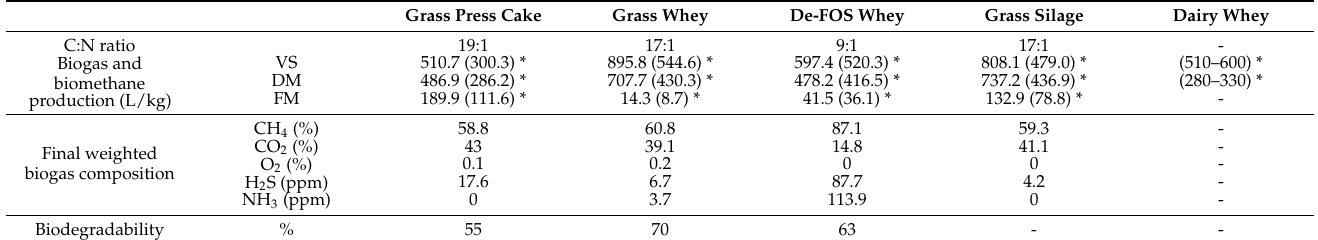
Table 3. Biogas and biomethane summary data for grass press cake, whey and de-FOS whey.